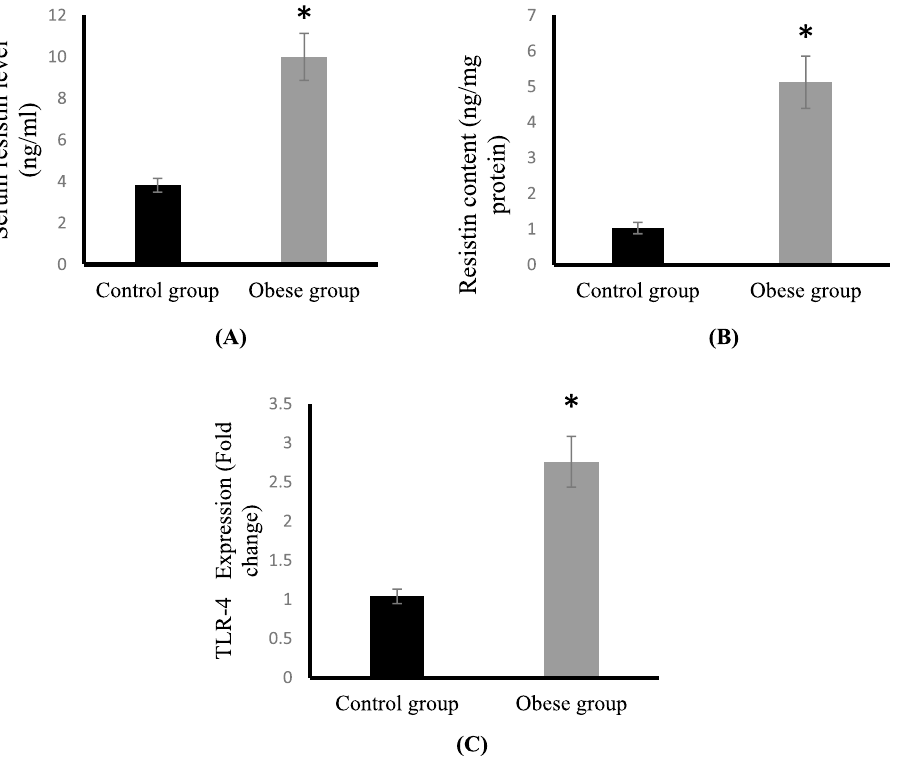
Figure 2. Serum resistin levels (ng/ml) ( A ), cartilage resistin content (ng/mg protein) ( B ) and cartilage TLR4 mRNA expression ( C ) in the control and obese